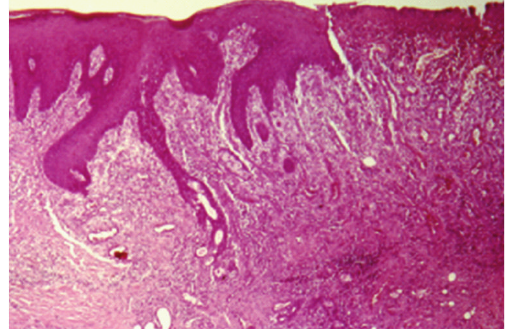
Figure 2: Histopathological picture shows a reactive necrotizing inflammatory process involving the minor salivary glands, with pseudoepitheliomatous hyperplasia of the overlying epithelium, but without evidence of dysplasia.